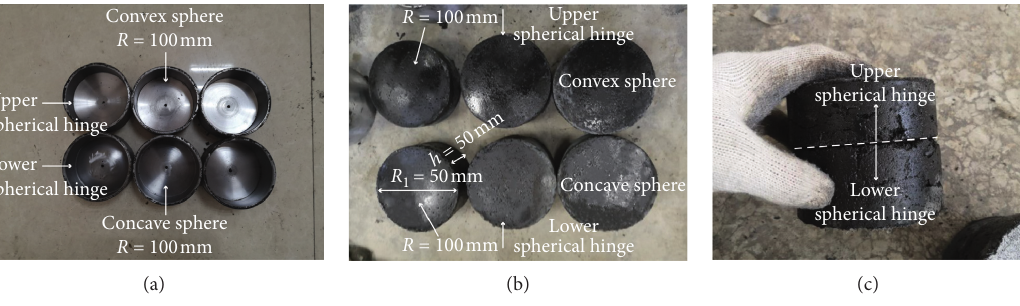
Figure 4: Steel form and spherical hinge specimen.